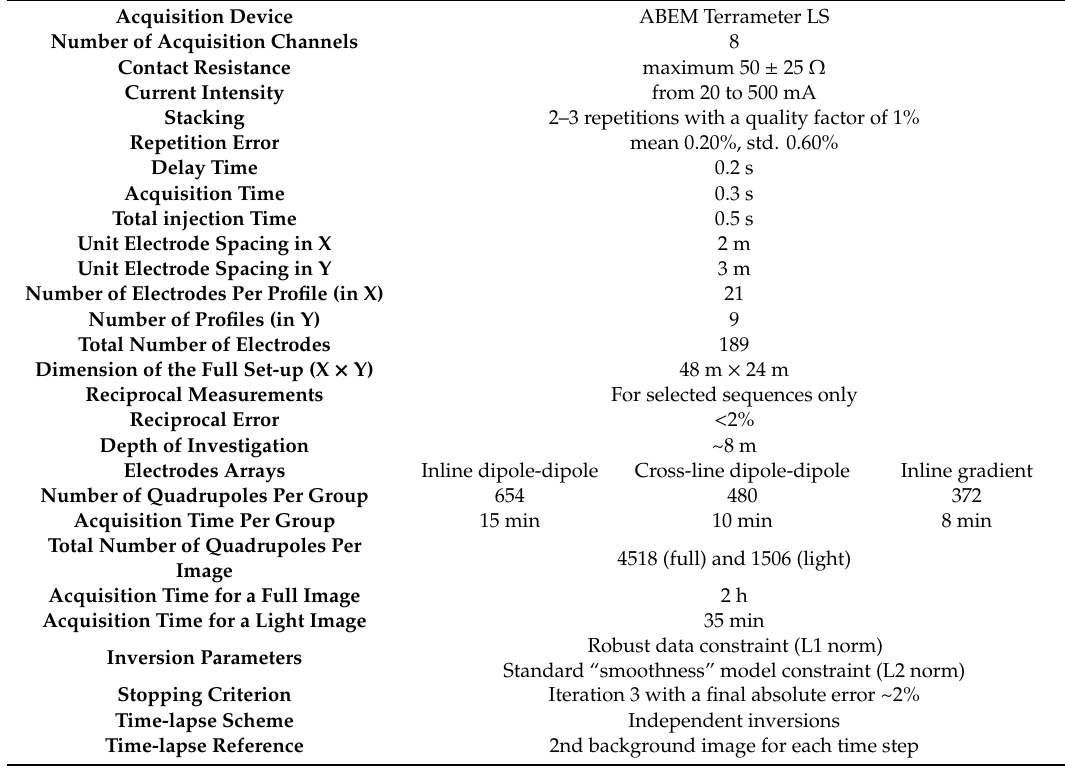
Table 1. ERT data acquisition and inversion